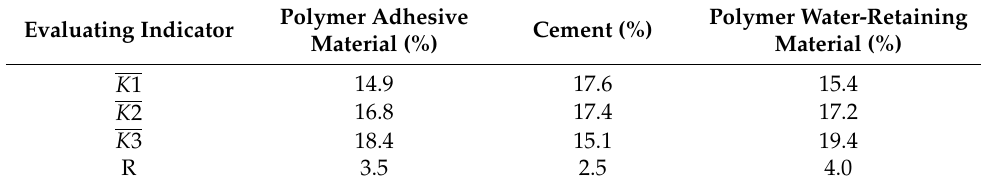
Table 6. Range analysis of plant growth test when using improved SPC.